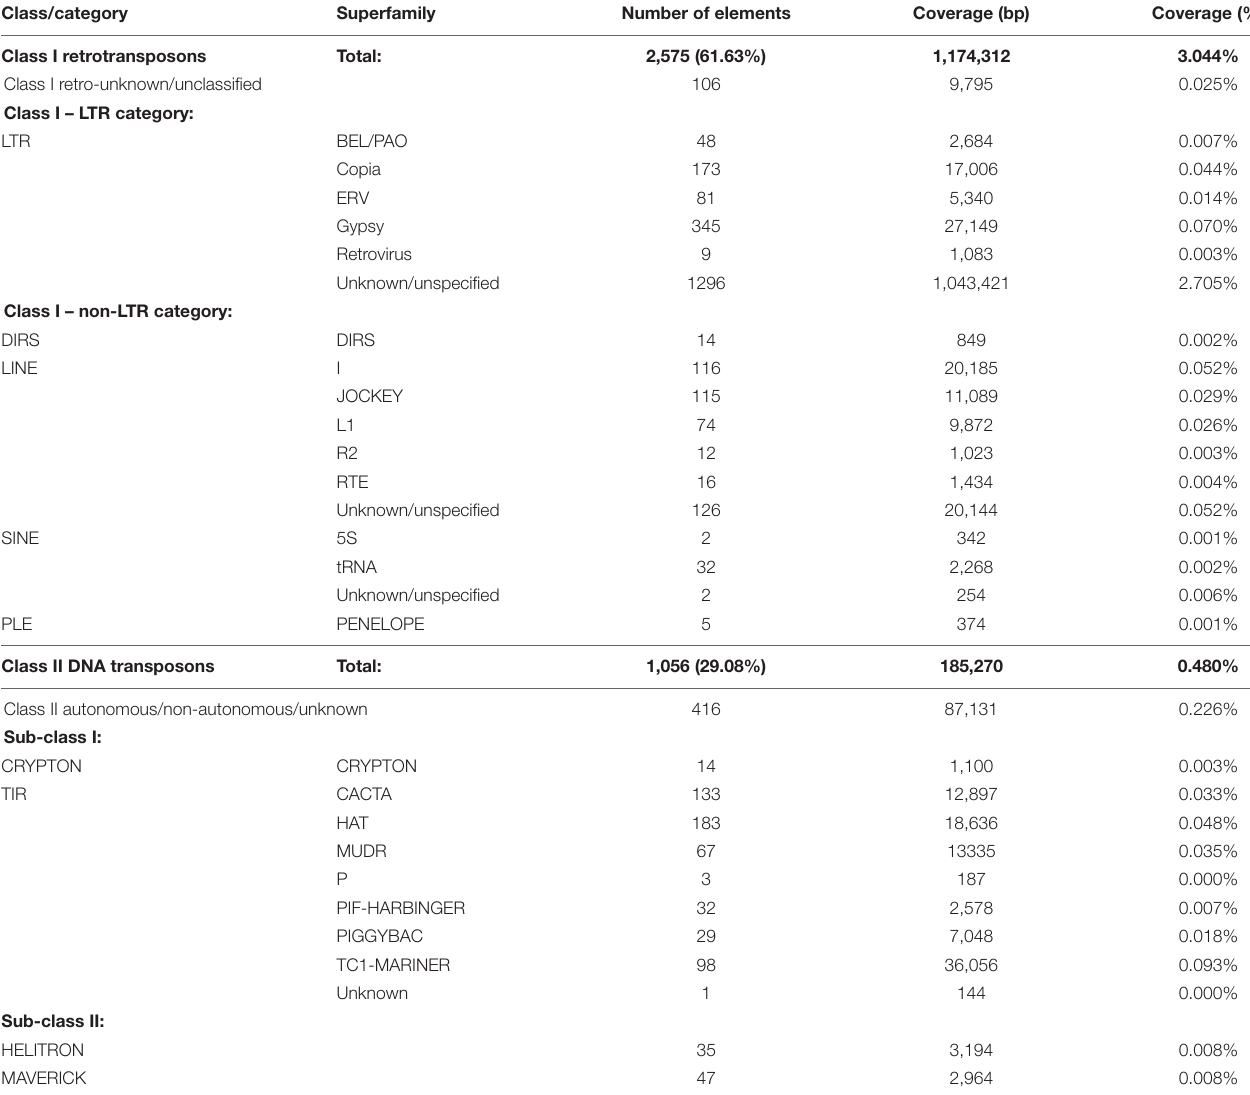
TABLE 2 | Class and Super Family composition of major families of Transposons in N. psidii MA3. Class/category